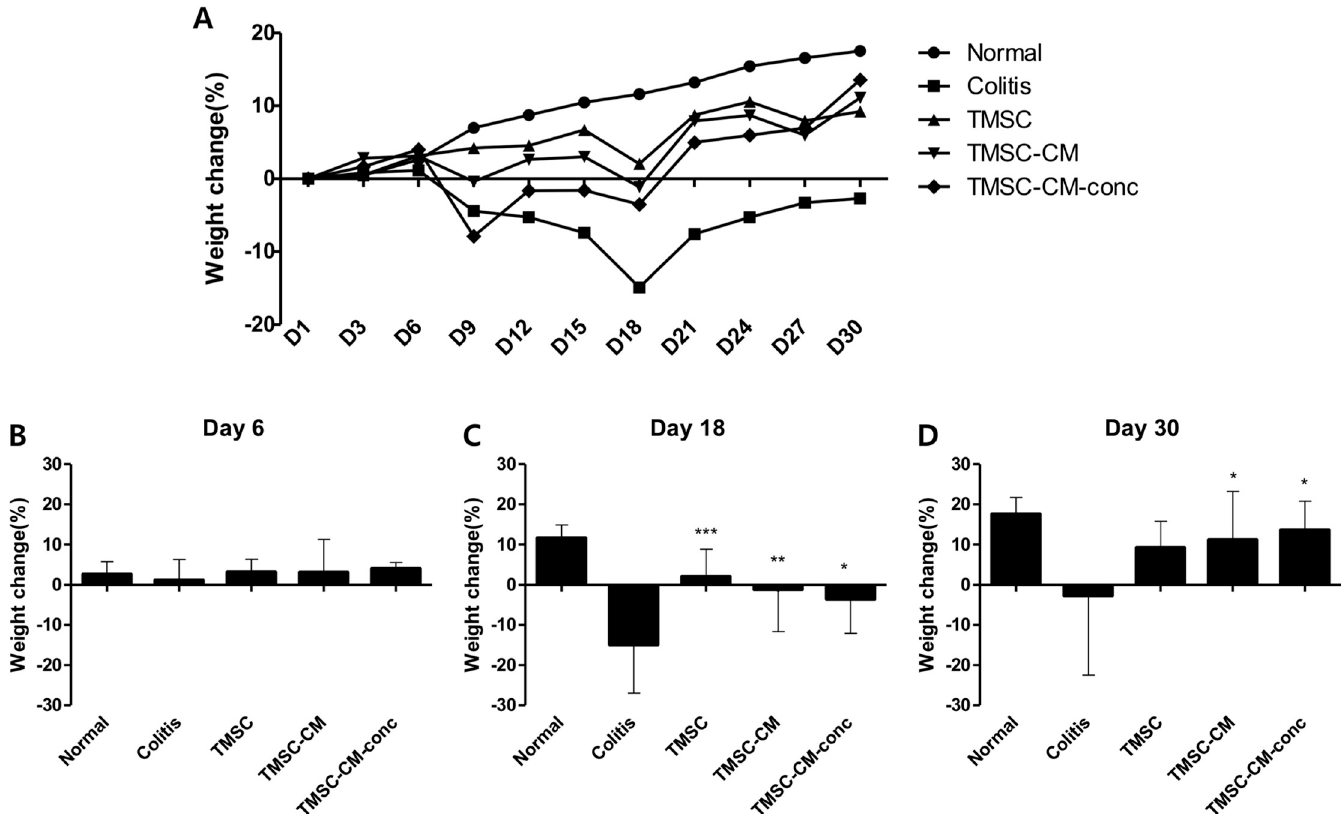
Fig 5. Weight recovery. The weight recovery at the 18th, 30th day of experiment was significantly greater in TMSC, TMSC-CM, and TMSC-CM-conc groups compared to that in colitis control group. (mean with standard deviation, � p < 0.05, �� p < 0.01, ��� p <